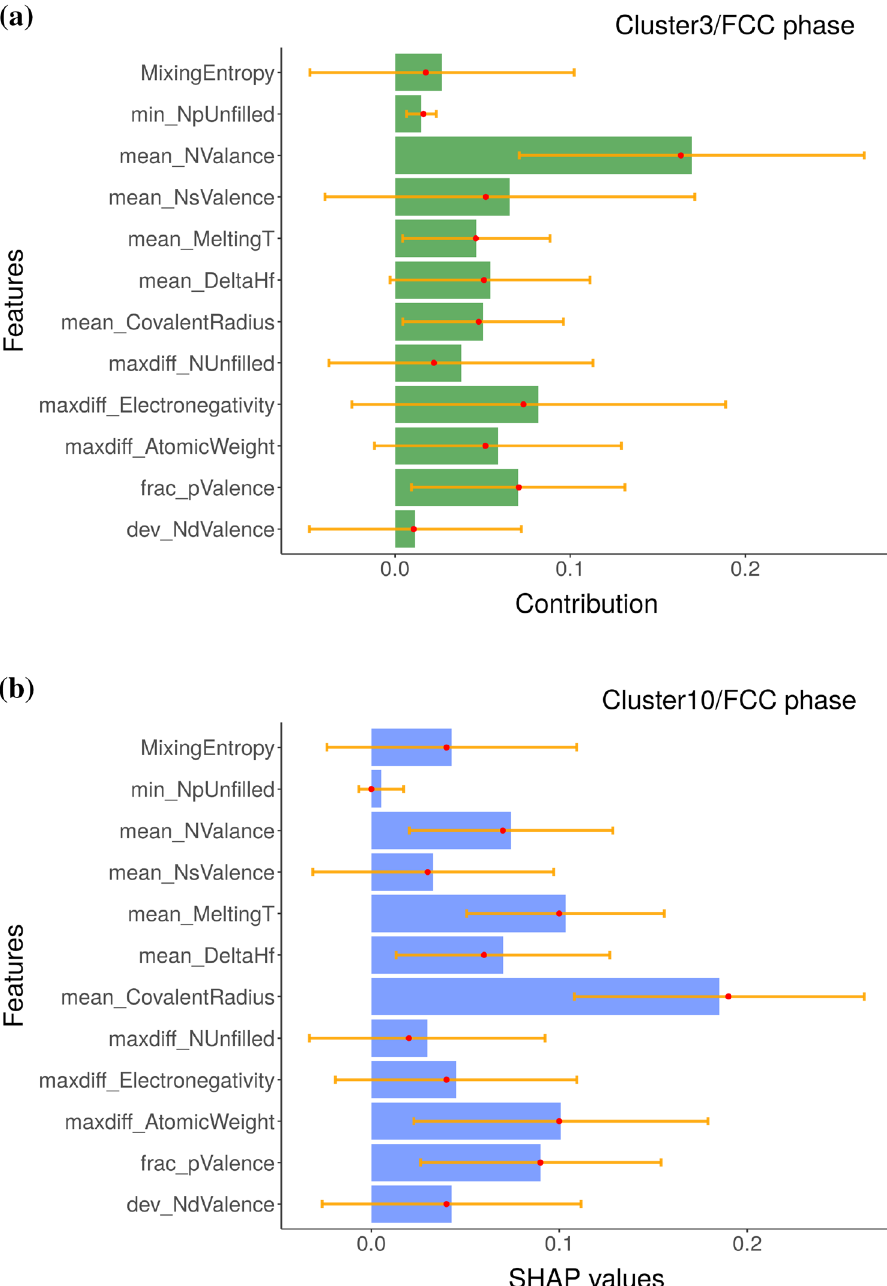
Figure 6. The ( a ) BD and ( b ) SHAP decomposition are plotted for the representative clusters (clusters 3 and 10, respectively), which are predicted to have FCC phase by the eSVM model. The size of each bar indicate the averaged contribution of the respective variables towards the overall prediction for a given instance. Red dots and yellow lines denote median values and error bars, respectively. The y-axis of SHAP plot are sorted in the same way as those of BD plot to facilitate the comparison of two